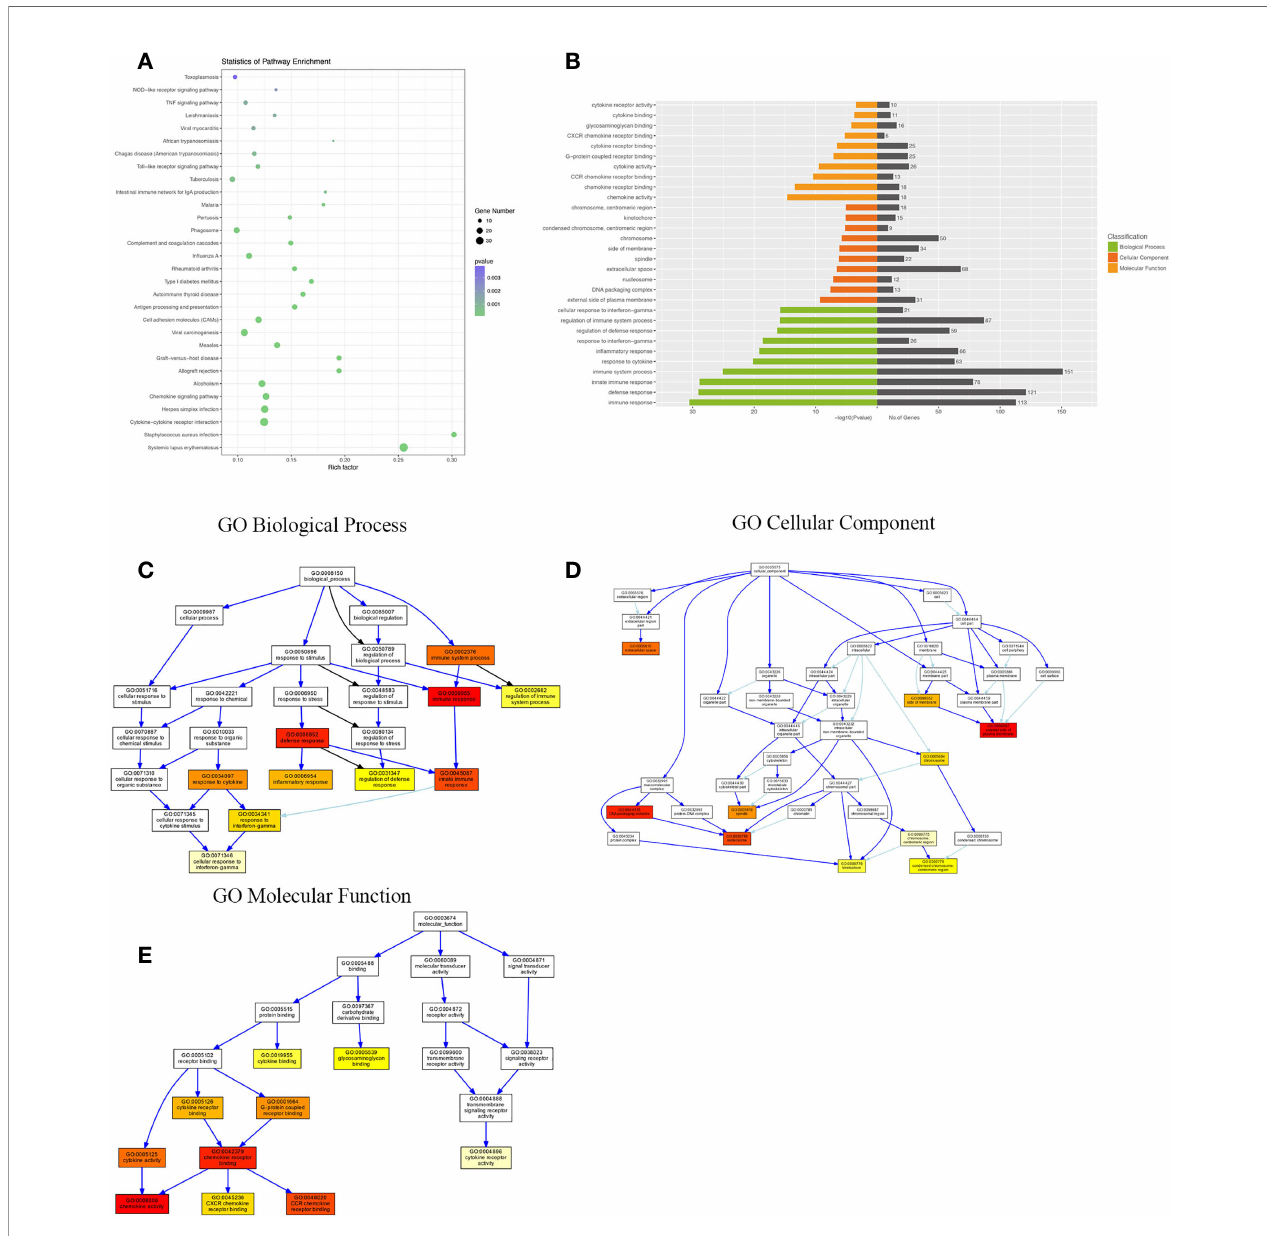
FIGURE 3 | KEGG (Kyoto Encyclopedia of Genes and Genomes) pathway and Gene Ontology (GO) analysis of DEGs between the uninfected mice and the WT- PCP mice. (A) KEGG pathway analysis of DEGs between the uninfected mice and the WT-PCP mice. (B) GO analysis of DEGs between the uninfected mice and the WT-PCP mice. (C) Changes in the biological processes of DEGs. (D) Changes in the cellular component of DEGs. (E) Changes in the molecular function of